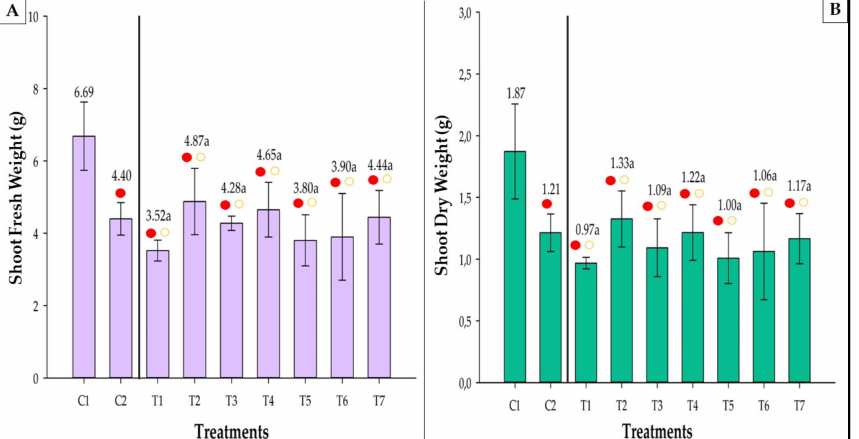
Figure 7. Shoot fresh ( A ) and dry ( B ) weights of strawberries inoculated with Azospirillum brasilense , Bacillus megaterium , and Brevibacillus fluminis , alone and in mixtures. Closed ( indicate comparisons withs Controls 1 and 2, respectively. Yellow and red circles indicate that the values are equivalent to, or lower than those observed in the controls according to Dunnet’s test ( p ≤ 0.05). Means followed by the same letter do not differ statistically according to Duncan’s test ( p ≤ 0.05). C1: control without inoculation + fertilization 100% of N and P; C2: control without inoculation + fertilization 30% of N and P; T1 : Azospirillum brasilense (Ab-v5); T2: Bacillus megaterium (0004); T3: Brevibacillus fluminis (MET12M2); T4: Ab-v5 + 0004; T5: Ab-v5 + MET12M2; T6: 0004 + MET12M2; T7: Ab-v5 + 0004 +